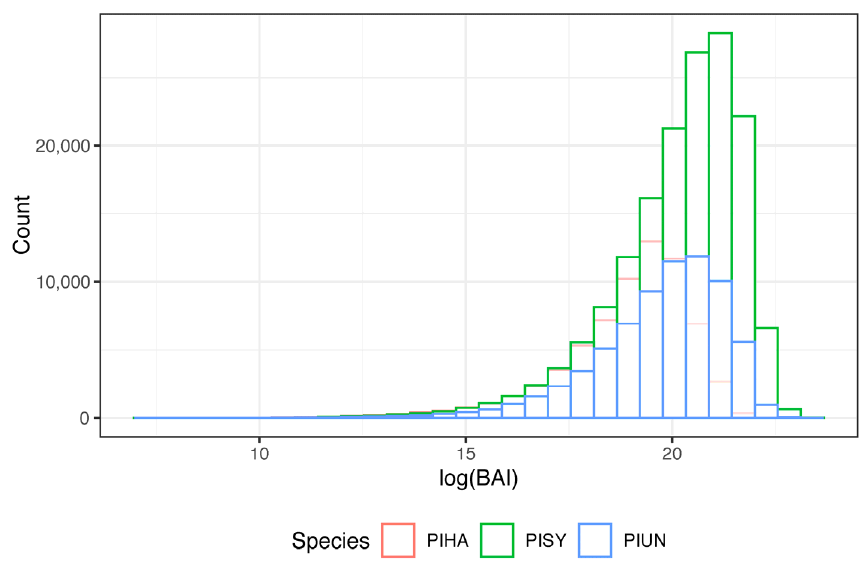
Figure 2. Variability in annual basal area for P. halepensis Mill, P. sylvestris L , and P. uncinata Ramond ex A.